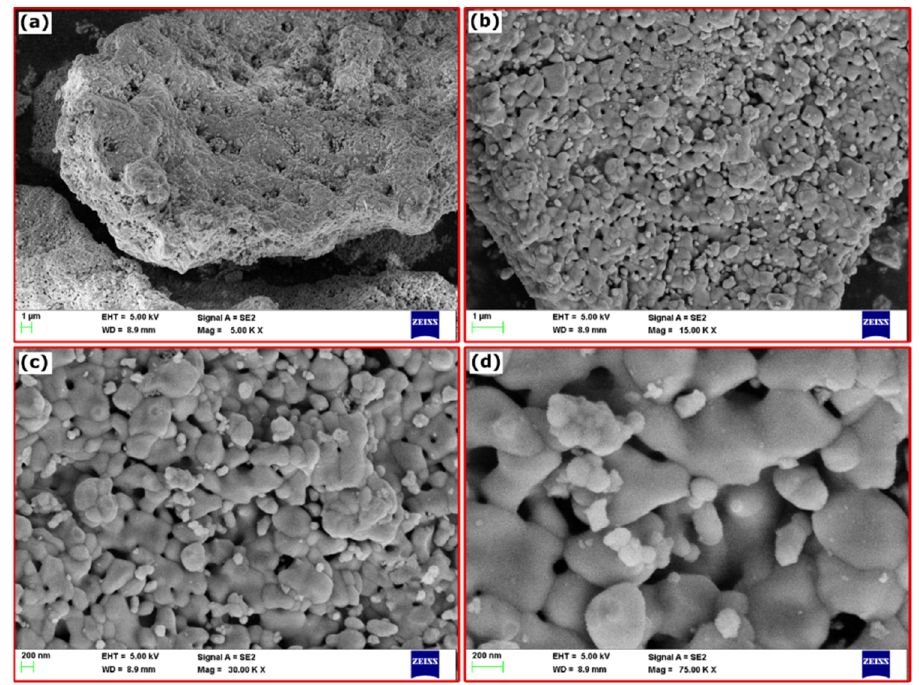
Figure 2. ( a – d ) FESEM of α‐ Fe 2 O 3 at different magnifications.